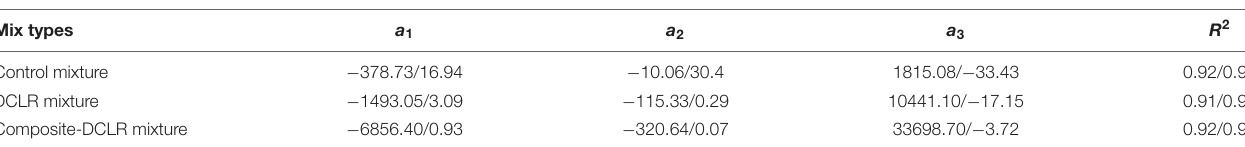
TABLE 5 | Regression coefficients for three asphalt mixtures.